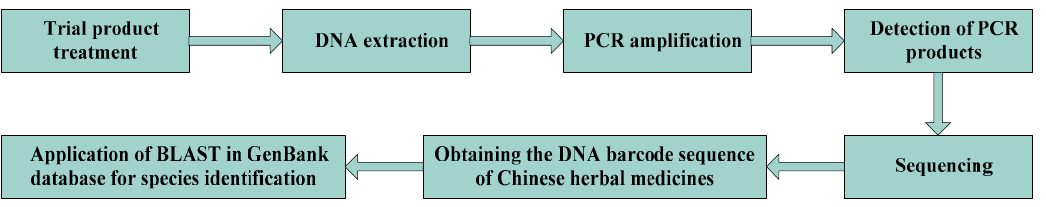
Figure 2. Molecular identification process of DNA barcoding in Chinese medicinal materials.